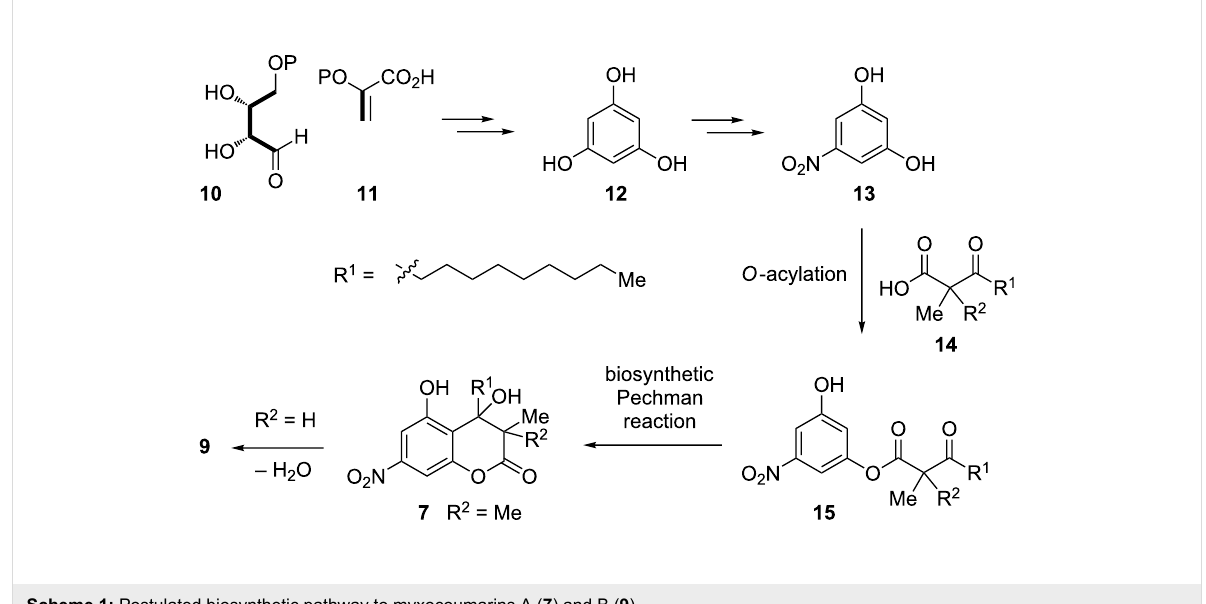
Scheme 1: Postulated biosynthetic pathway to myxocoumarins A ( 7 ) and B ( 9